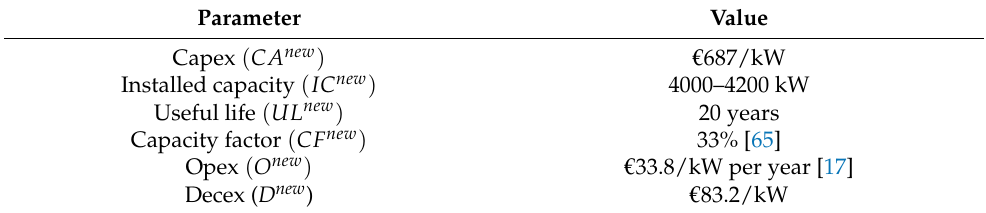
Table 8. Case 5: Turbine characteristics for full repowering (Vestas V